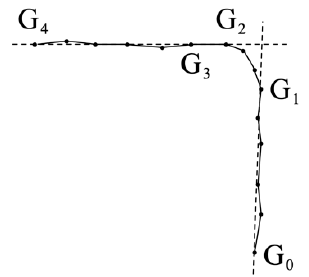
Figure 1. Gyroscope drift estimation.